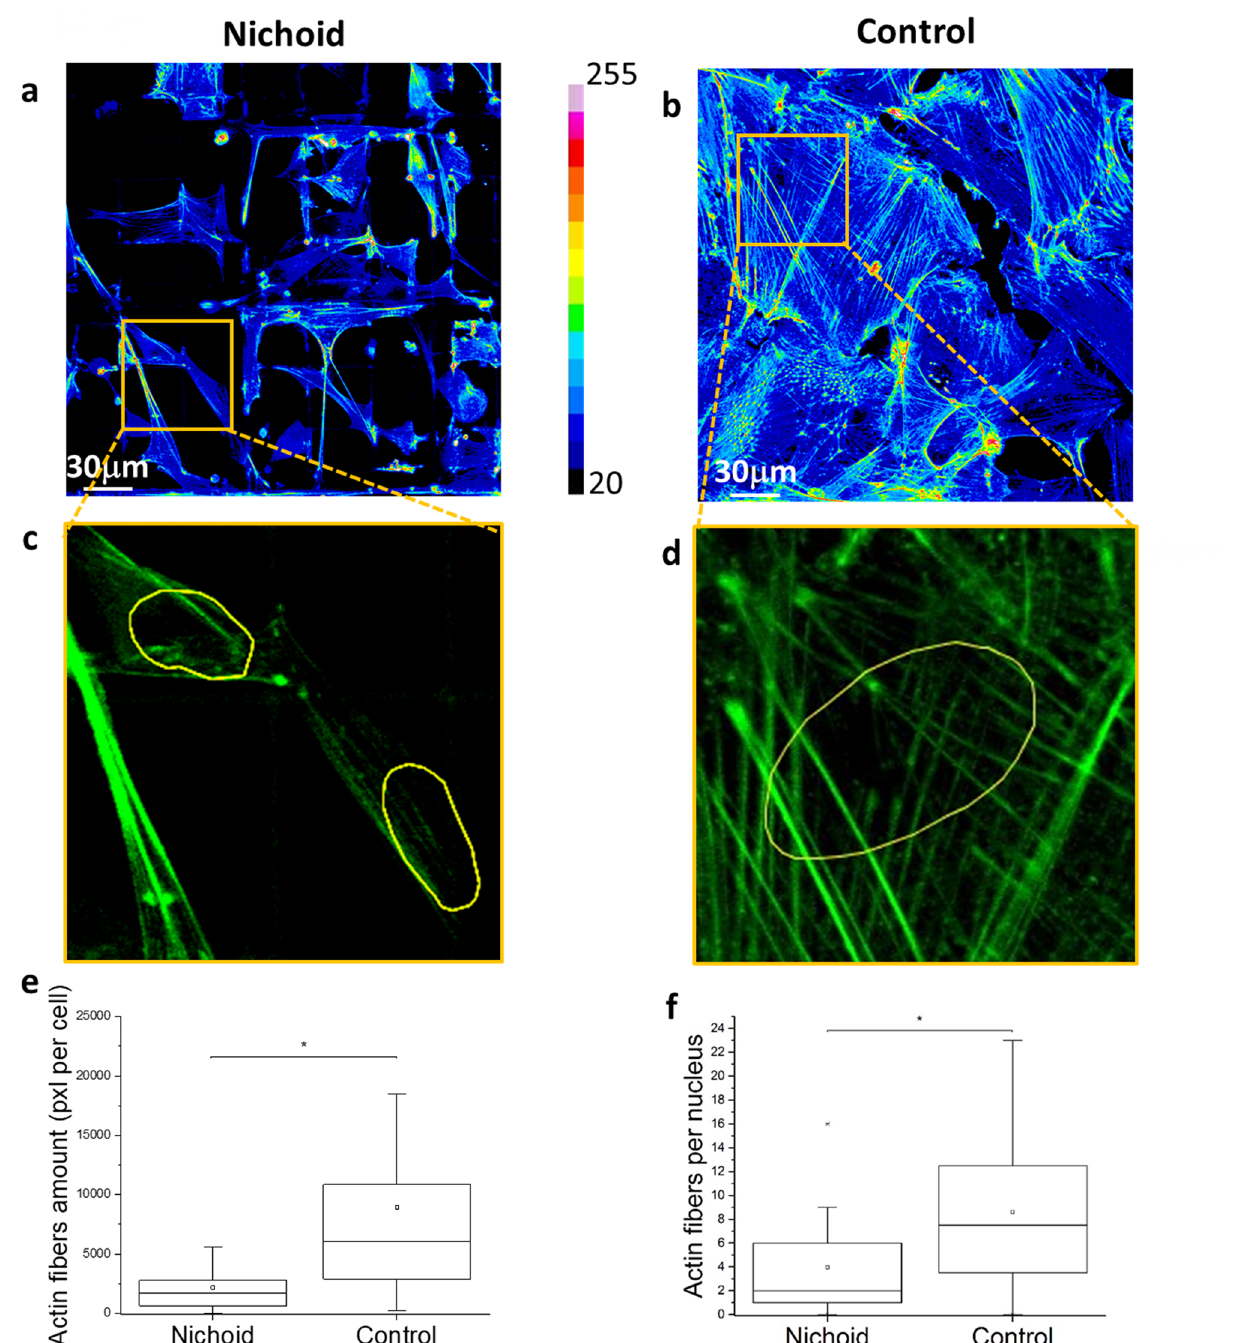
Figure 3. Spatial organization of actin filaments in MSCs adhering to the Nichoid artificial niche. ( a,b ) Representation of the actin fiber distribution in MSCs by using the pixel intensity color scale. ( c,d ) Representative images of actin fibers adjacent to the cell nuclei (represented by the yellow ROI). ( e,f ) Quantification of the number of actin fibers per cells and the number of actin fibers. Graphs ( e ) and ( f ) statistics: Mann–Whitney test. *Corresponds to p <